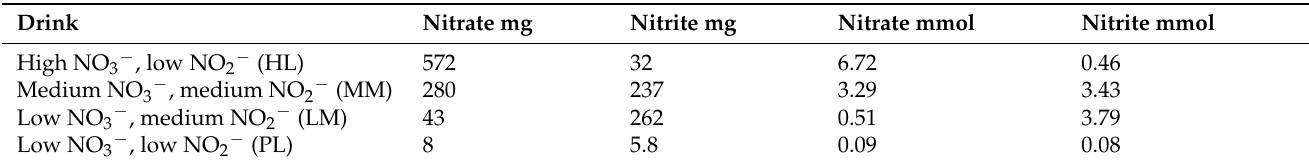
Table 1. Nitrate and nitrite content of the drinks (per 250 mL) (as determined by high-performance liquid chromatography